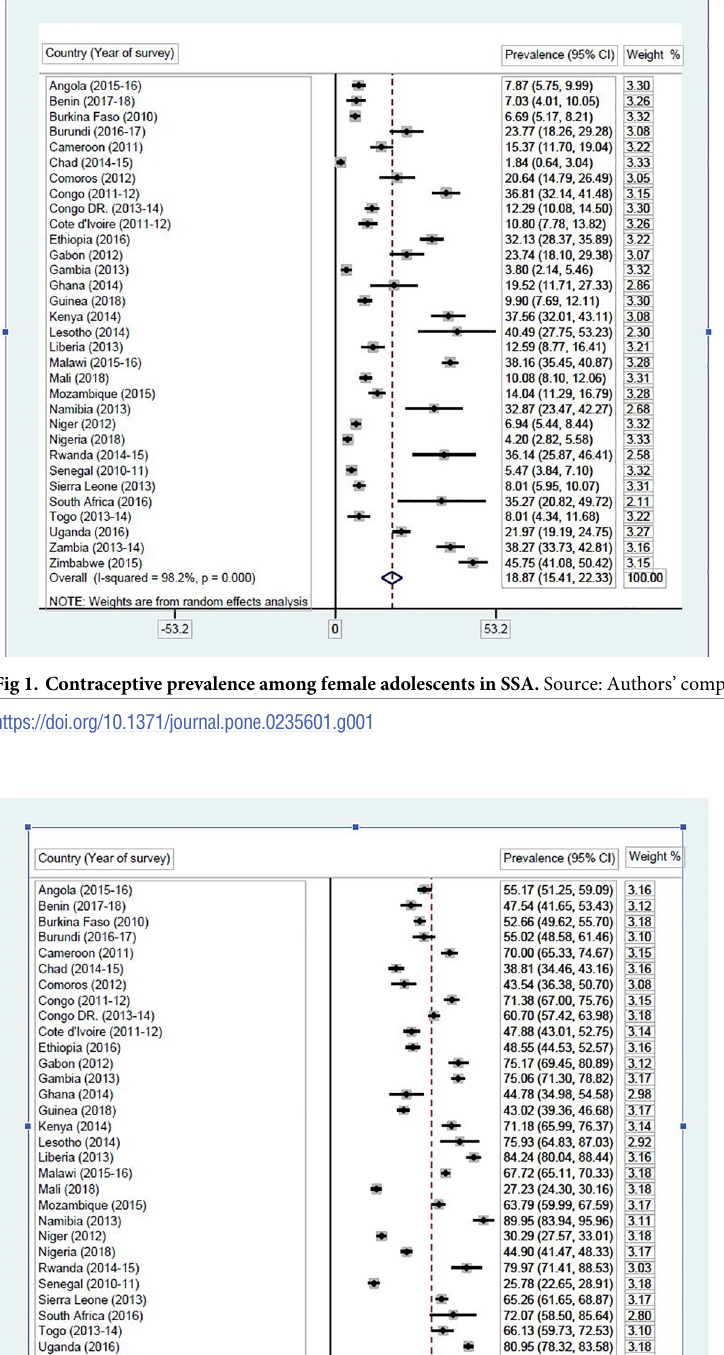
PLOS ONE | https://doi.org/10.1371/journal.pone.0235601 July 10,